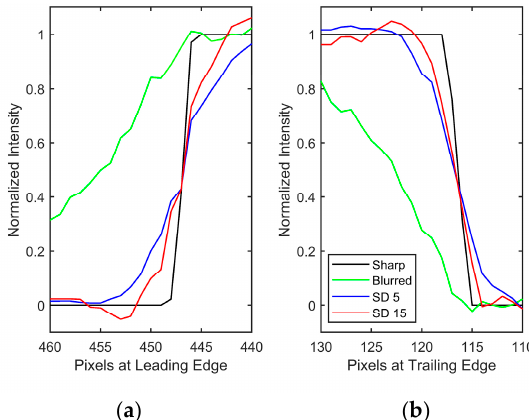
Figure 10. Comparison at the interface of 90 kPa and 70 kPa at r / R =0.95 at the (a) leading edge and (b) trailing edge. Rotation is toward increasing pixel values. ( b ) trailing edge. Rotation is toward increasing pixel values.